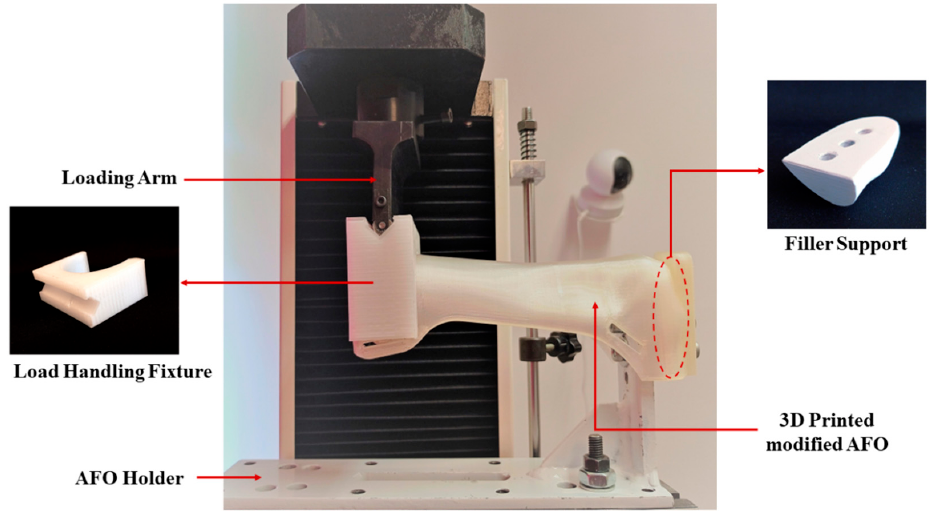
Figure 4. Strength testing setup at the